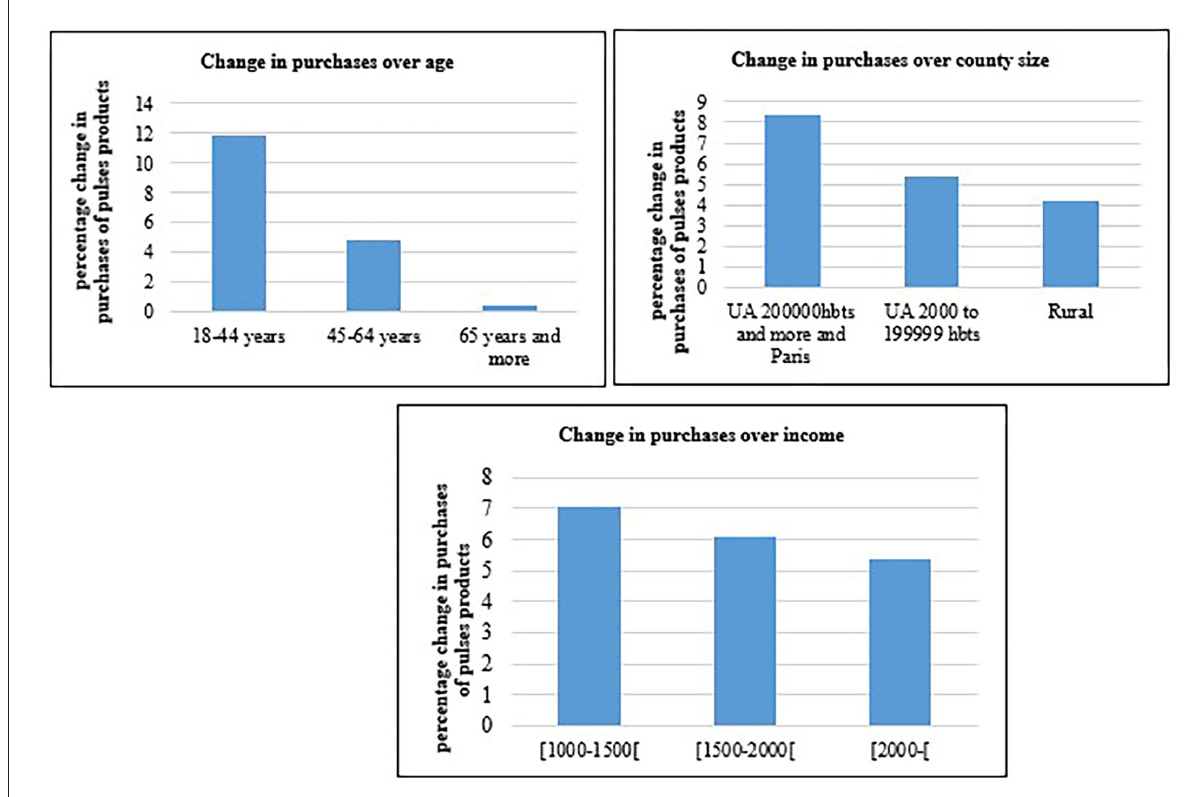
FIGURE3 Change (%) in quantities purchased of pulses products over age groups, county size and income